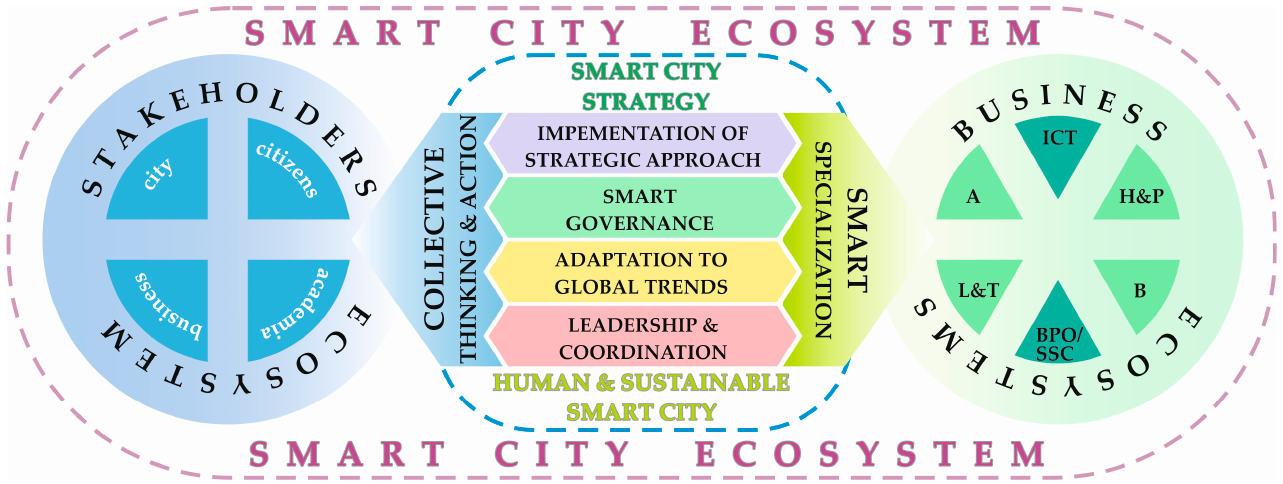
Figure 5. Smart City Ecosystem Model (SCEM). Abbreviations: Key Specializations: ICT—Information and Communication Technologies; BPO/SSC—Business Process Outsourcing/Shared Services Centers; Complementary Specializations: A—Automotive, L & T—Logistic and Transport, H & P—Health and Pharmacy, B—Biotechnology.